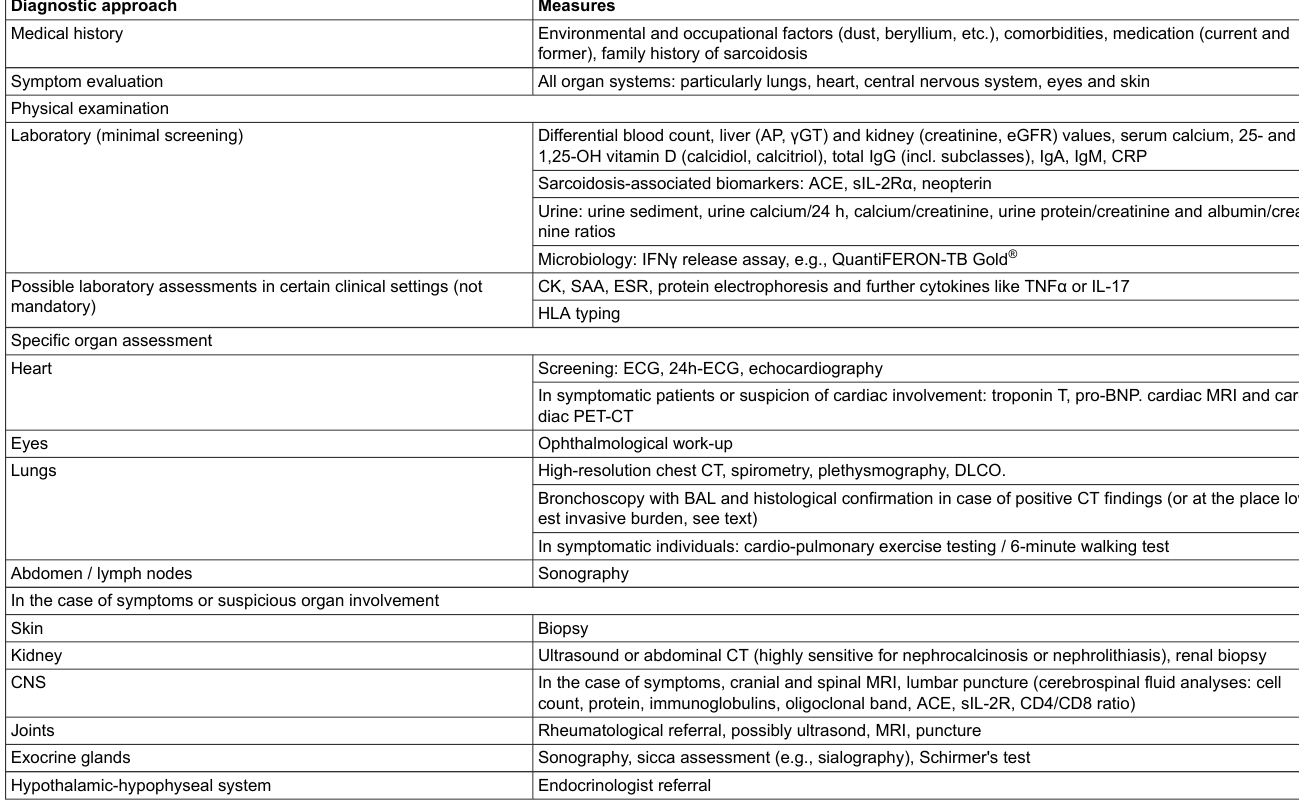
Table 2: Diagnostic approach for minimum organ screening assessment. Diagnostic